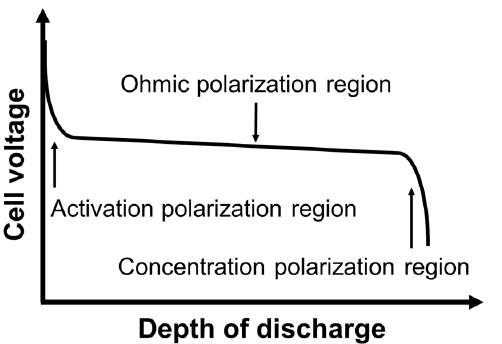
Figure 4. Typical discharge curve of a battery cell, showing three different regions of